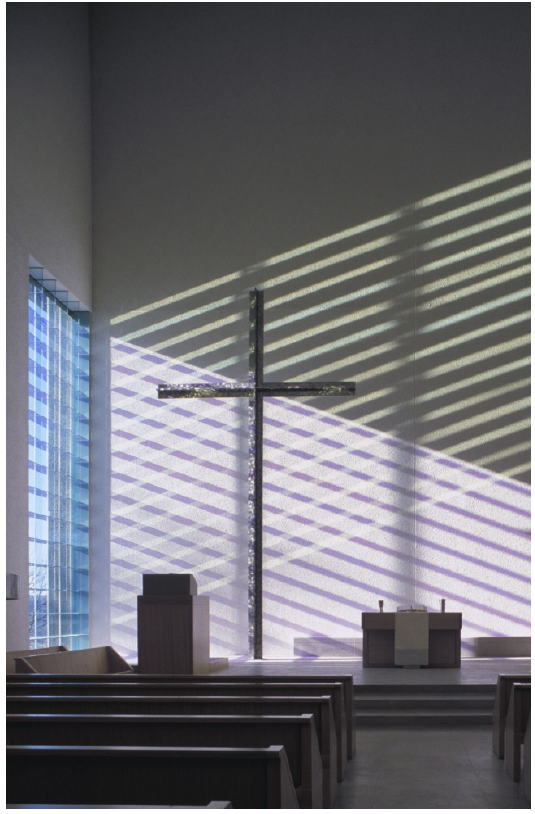
Figure 10: The Structural Glass Prisms provide multiple simultaneous readings of light